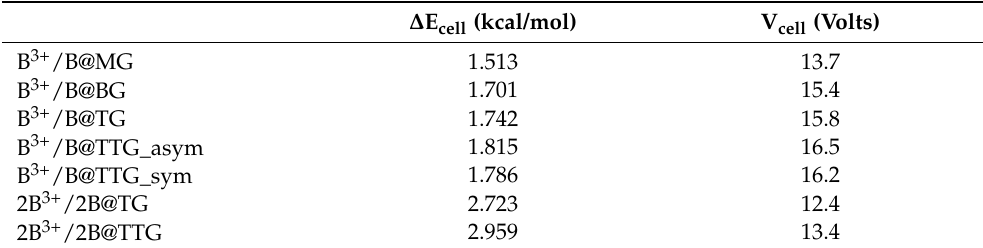
∆ E cell (kcal/mol) V cell (Volts)